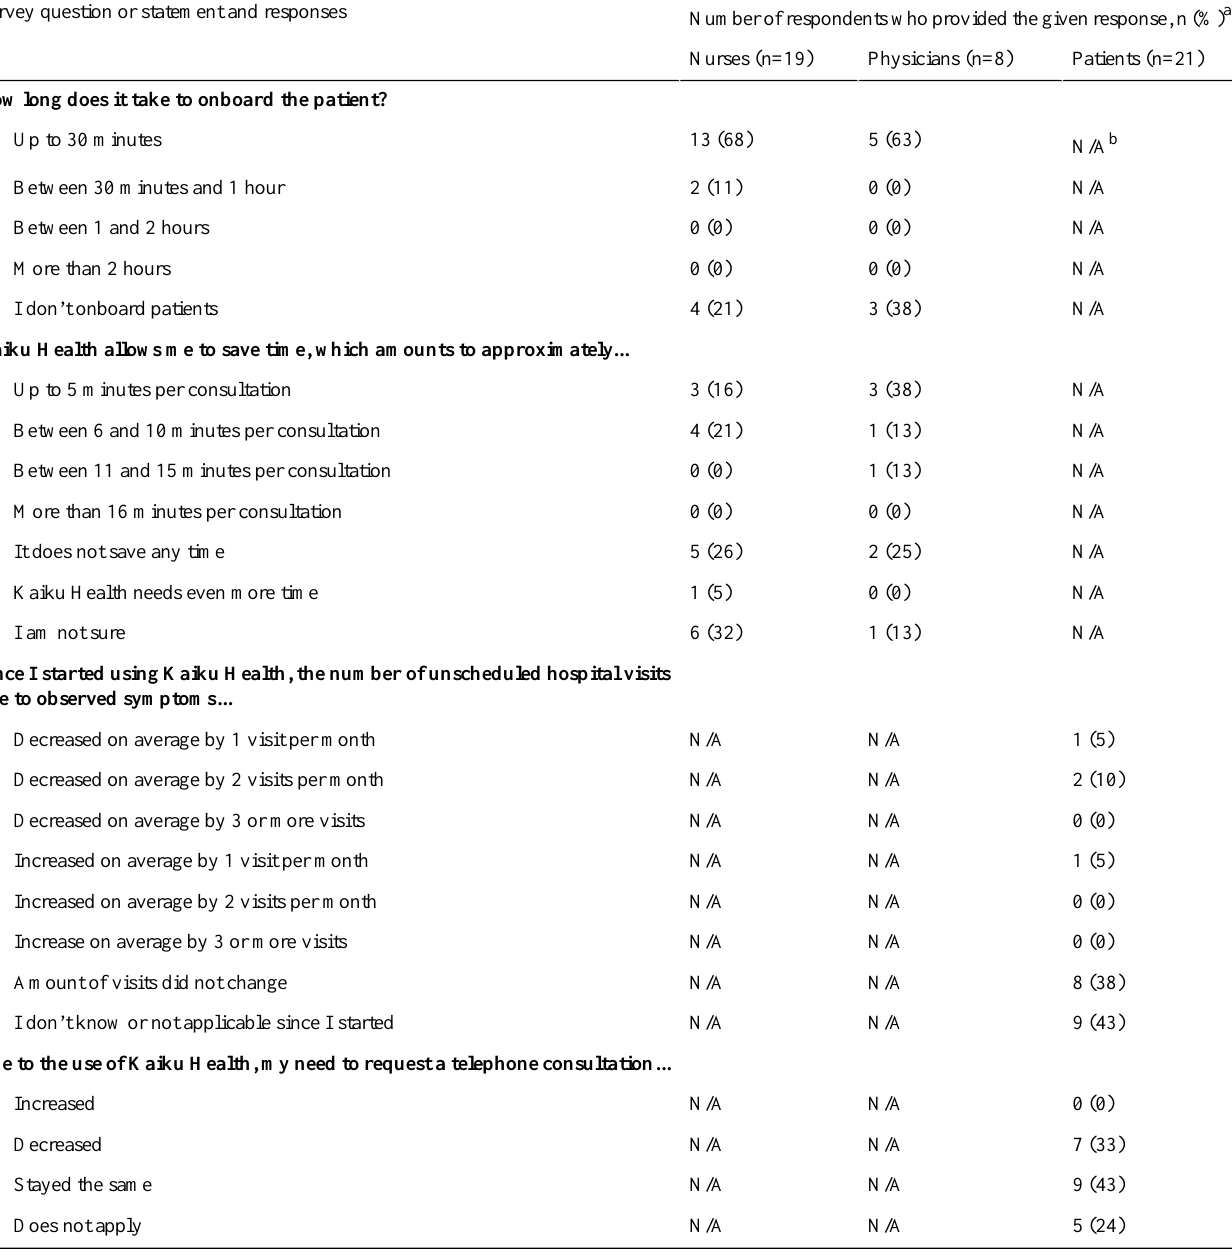
Number of respondents who provided the given response, n (%) a Survey question or statement and responses